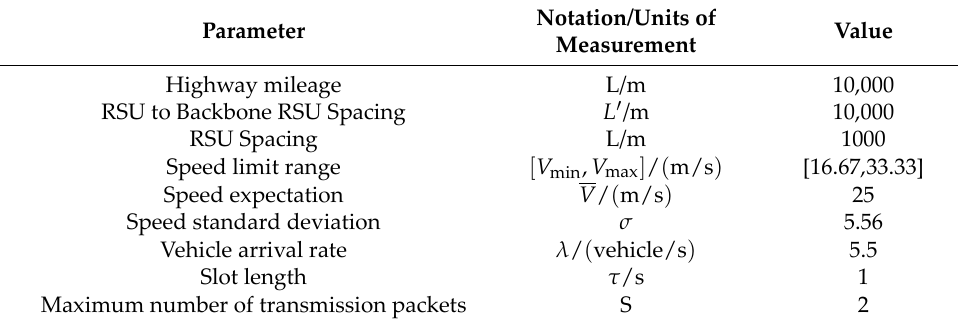
Table 1. The simulation parameters.